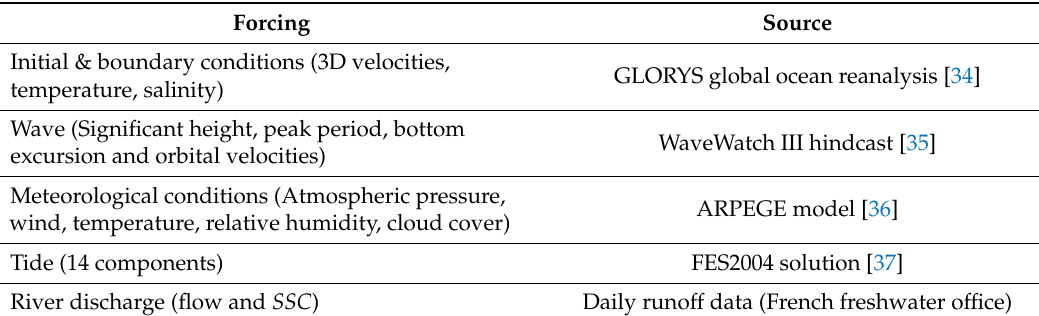
Table 1. Realistic forcings used in 3D